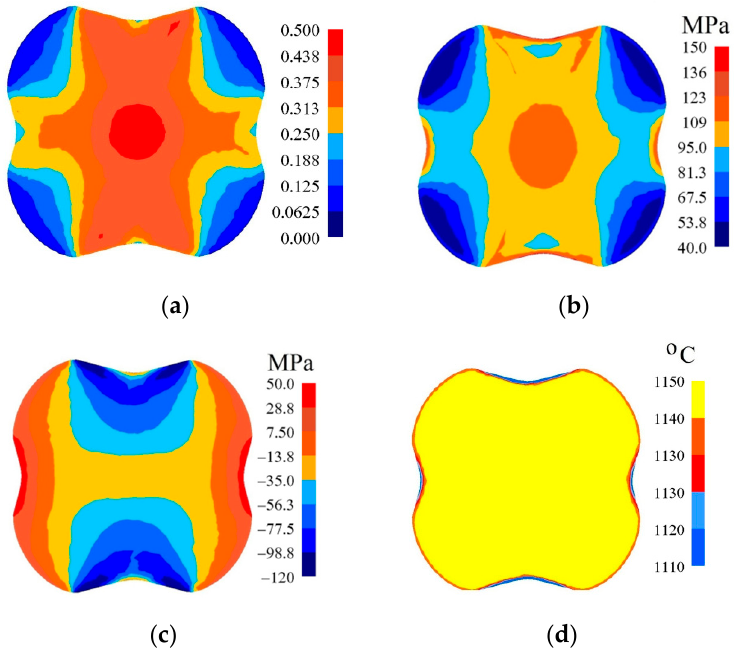
Figure 8. Distribution of the effective strain ( a ), effective stress ( b ), mean stresses ( c ), and temperature ( d ) on the cross-section of the workpiece in the course of forging in convex anvils after the second pass ( α c = 150°, ε c = 0.22).